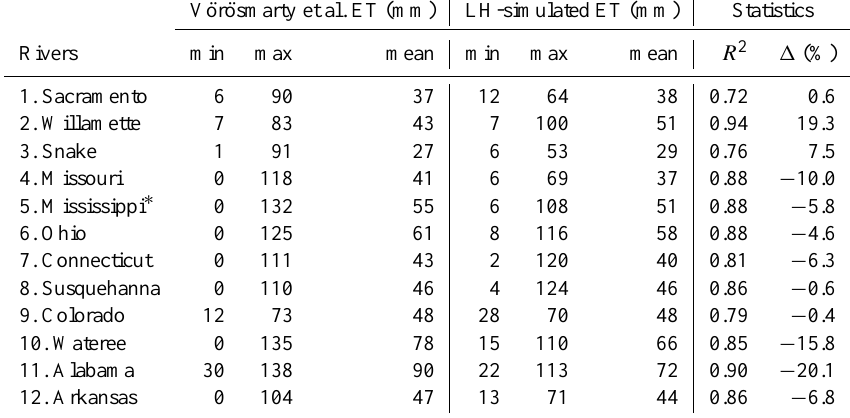
Table 5. Comparison between LH-simulated and V¨or¨osmarty et al. ET (V¨or¨osmarty et al., 1998) data in12 major river watersheds in the US. V¨or¨osmarty et al. ET (mm) LH-simulated ET (mm)